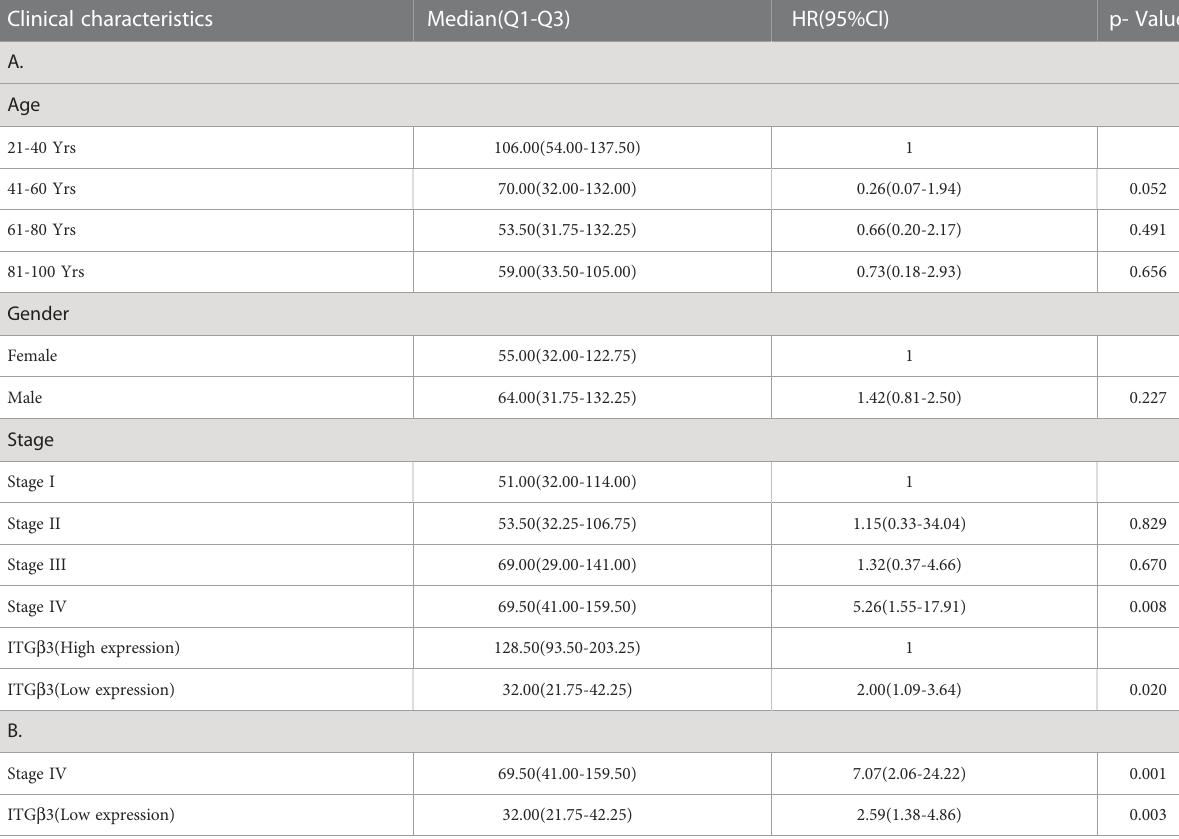
TABLE 1 (A) Association with overall survival and clinicopathologic characteristic in patient data from TCGA using Cox regression.